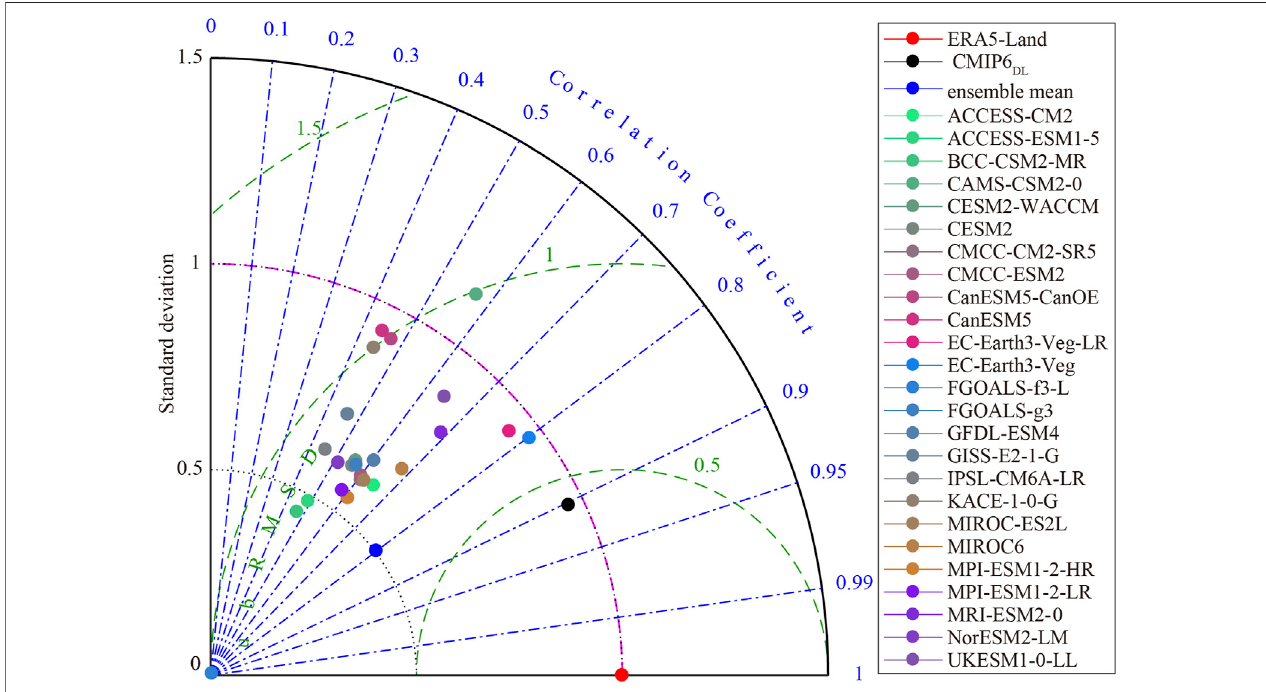
FIGURE 5 | Normalized Taylor diagram presenting a comparison of CMIP6 DL dataset with ERA5-Land, the ensemble mean, and 25 models from CMIP6 in 2008 – 2014. The diagram shows the correlation, ubRMSD, and ratio of the standard deviation.